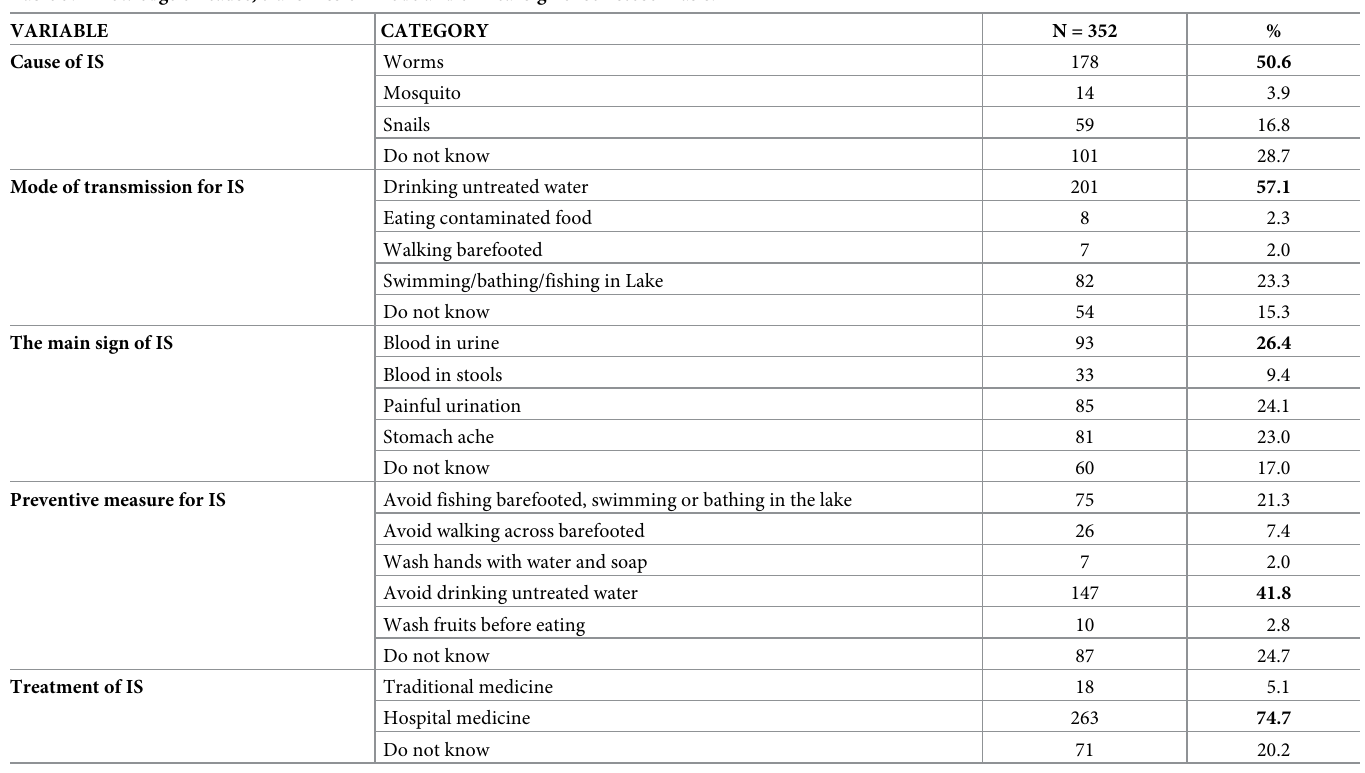
Table 3. Knowledge on cause, transmission mode and clinical sign of